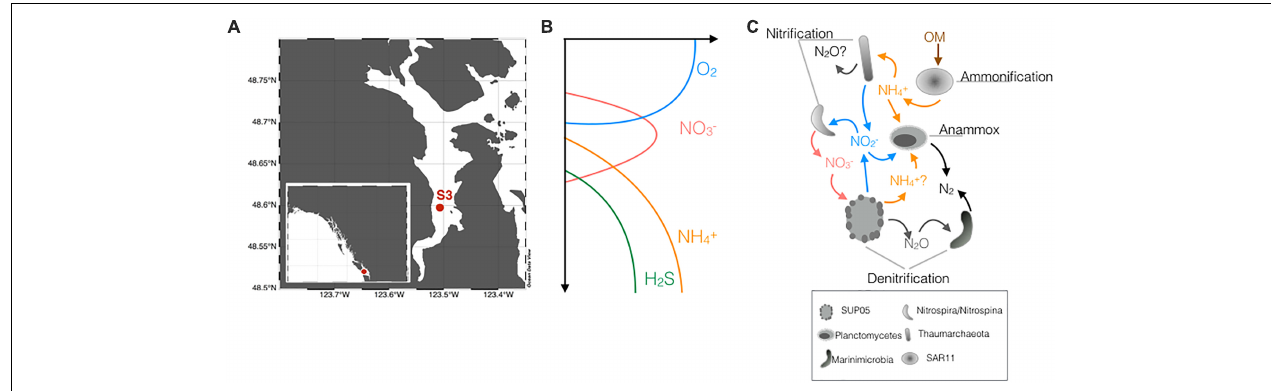
FIGURE 1 | (A) Sampling of Station S3 in Saanich Inlet, on Vancouver Island, British Columbia (Canada). Sampling of S3 happened once a month within a historic time series data collection. (B) Typical redox gradients found in SI. These gradients move vertically depending on the season. (C) Active microbial metabolisms of the N-cycle present along the redox gradients of SI, modified from Hawley et al. (2014).